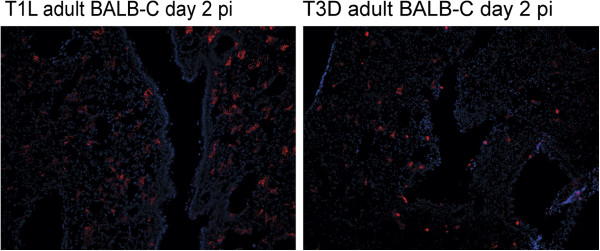
High magnification images of T1L and T3D infected adult lungs. The 2 day post infection images shown in Figure 5 are enlarged here to demonstrate more clearly the presence of reovirus antigens in alveolar tissues. Size bars are 100 μM.